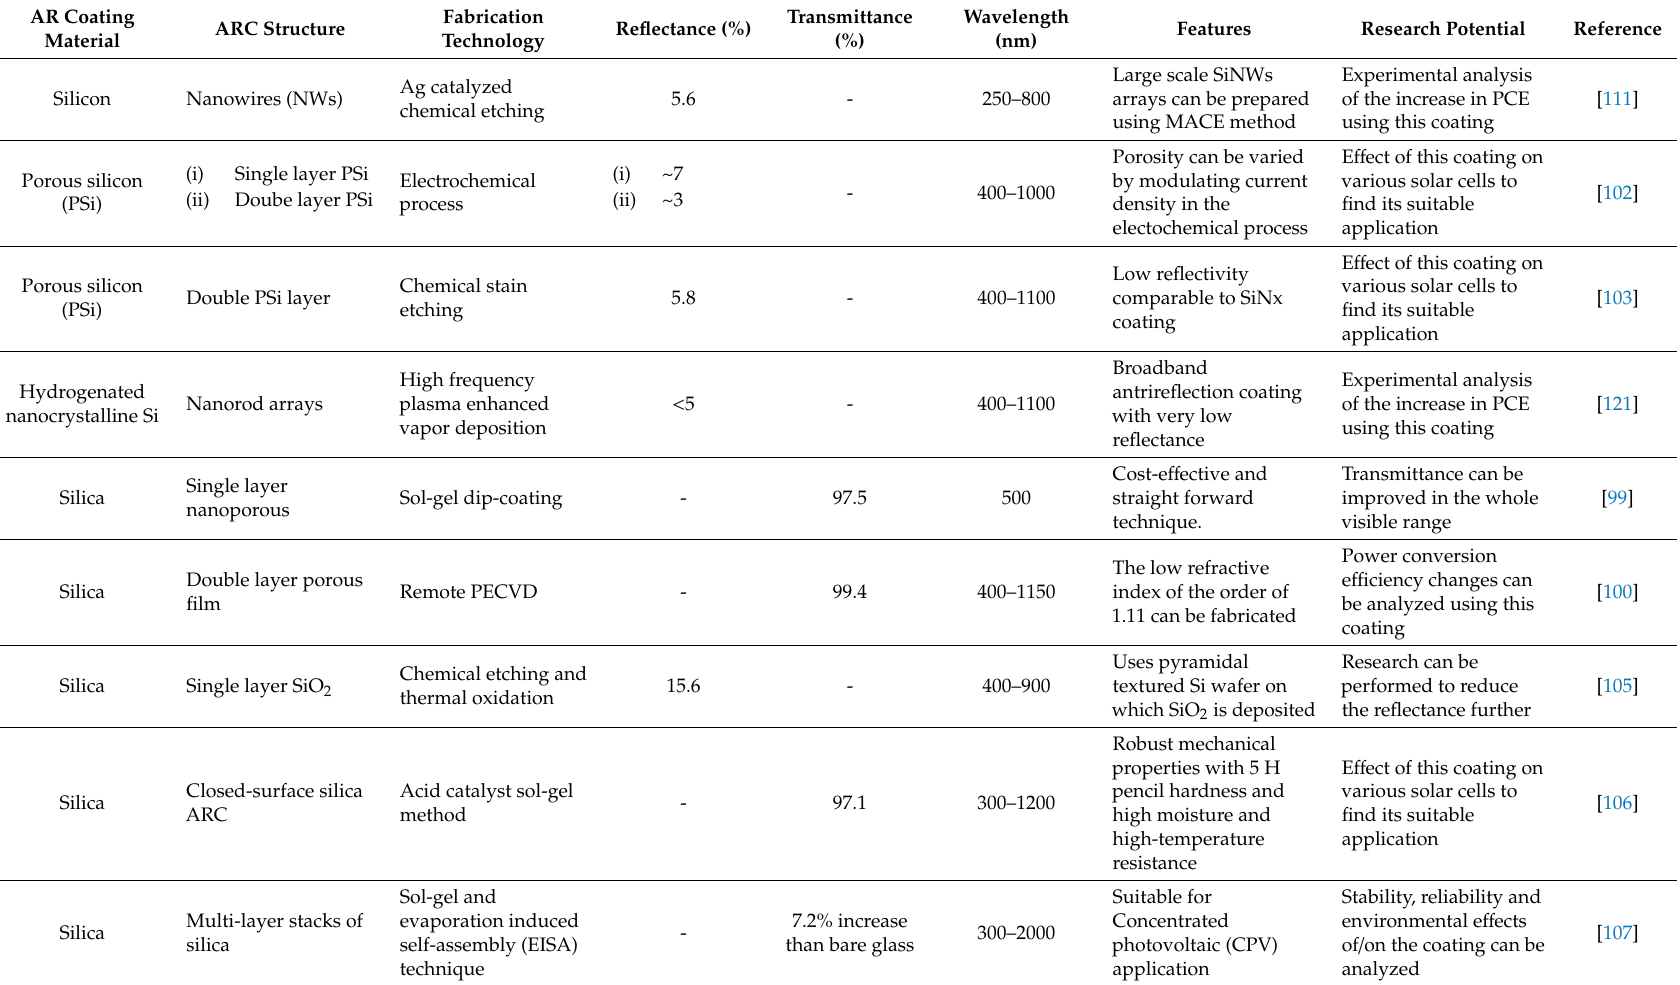
Table 3. Silicon based antireflection